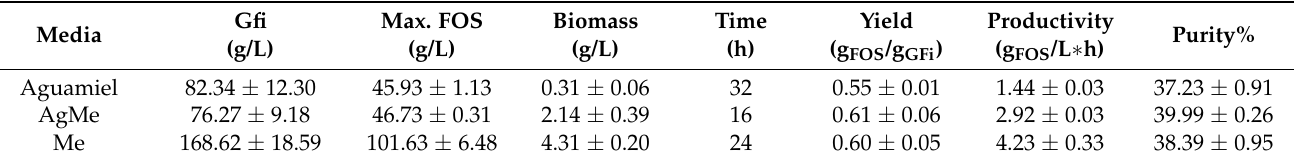
Table 2. Fructooligosaccharides (FOS) maximum production (Max. FOS), yield, and purity achieved during fermentation with the different media evaluated at optimal fermentation time.